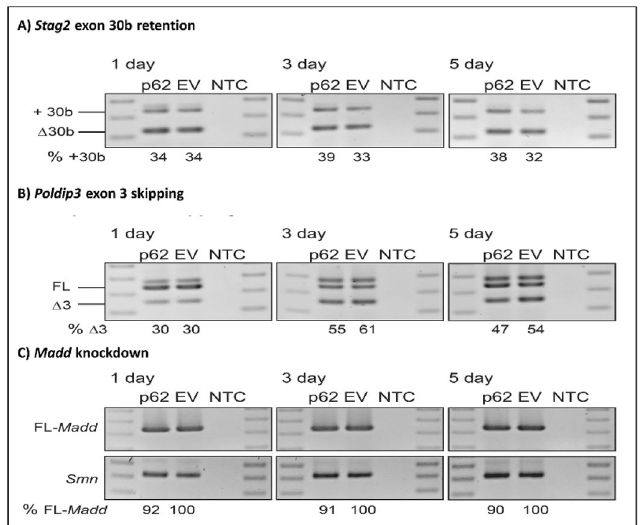
Figure 10. p62 overexpression leads to loss of TDP-43-mediated RNA regulation. Effects of p62 overexpression on alternative splicing of selected genes, showing RT-PCRs across Stag2 ( A ), Poldip3 ( B ) and Madd ( C ) transcripts following transfection with p62 overexpression vector (p62) or the empty vector control (EV) and incubated for 1, 3 and 5 days. An RT-PCR across Smn transcripts were used as a loading control. A 100 bp ladder was loaded on either side of the gel and a no template control (NTC) was included in the final lane. Full- length (FL) and exon skipped (Δ) transcripts are annotated and the percentage of specific transcripts are detailed below each